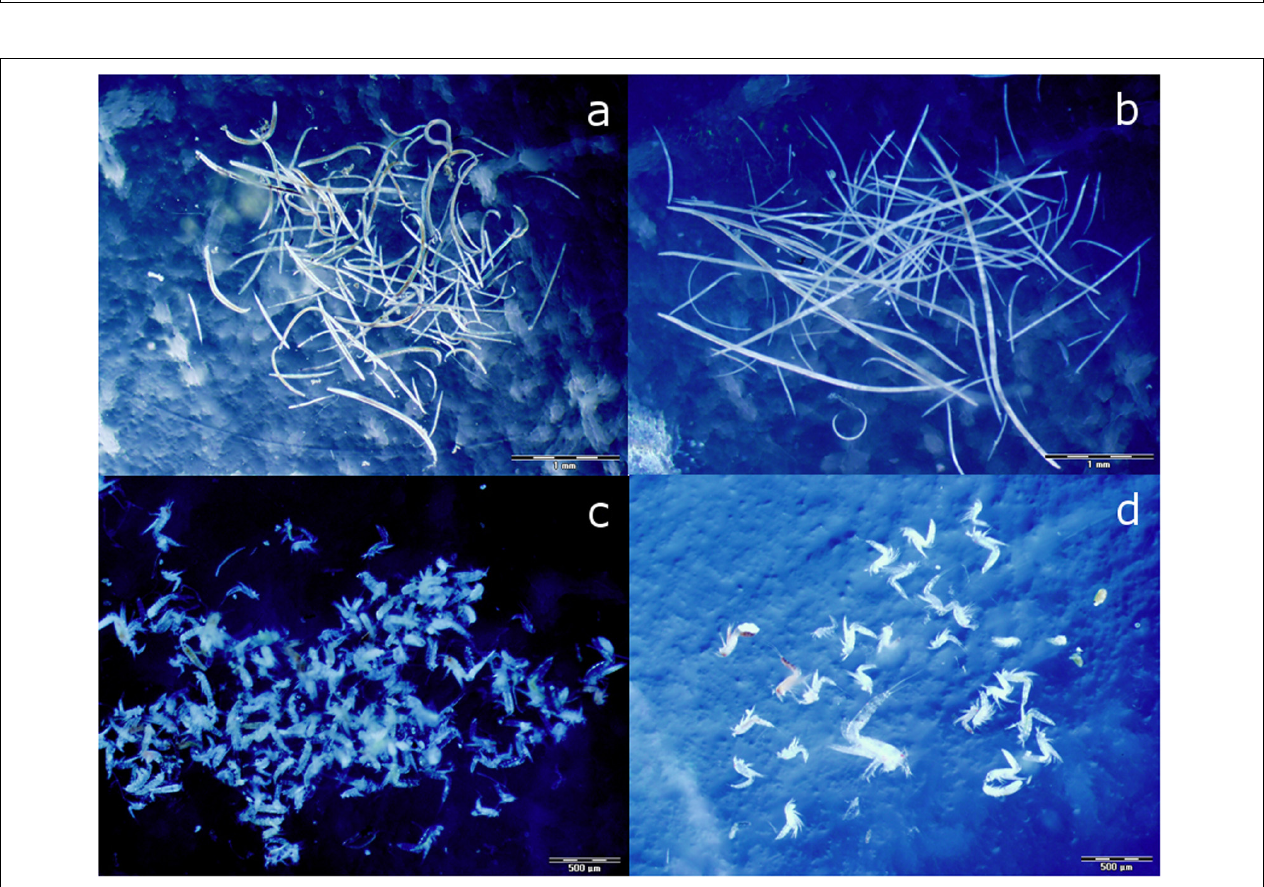
FIGURE 1 | (a) Study area and the location of the fish farm in the Bay of Piran, Adriatic Sea. (b) Experimental setup. CAGE indicates the cores retrieved just under the fish farm and OUT indicate cores retrieved 100 m away from the farm. On top of the sediment of 10 cores 13 C labeled diatoms were added prior to 5-day incubation, and are indicated with an asterisk.